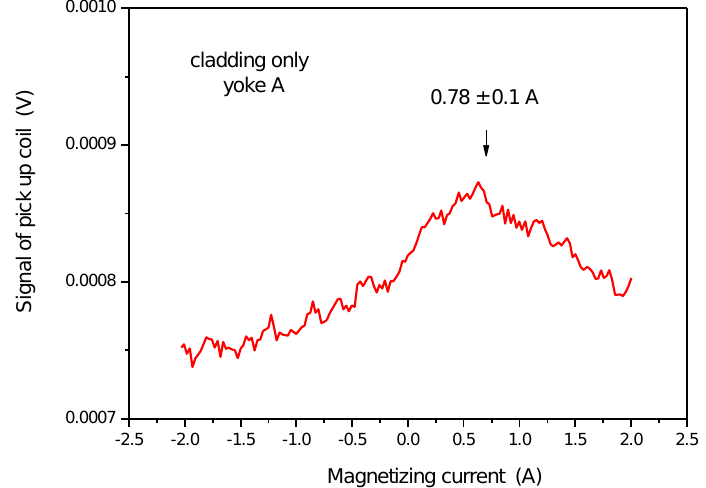
Figure 10. Signal of the pick-up coil as a function of the magnetizing current, measured on the pure cladding by applying Yoke A.